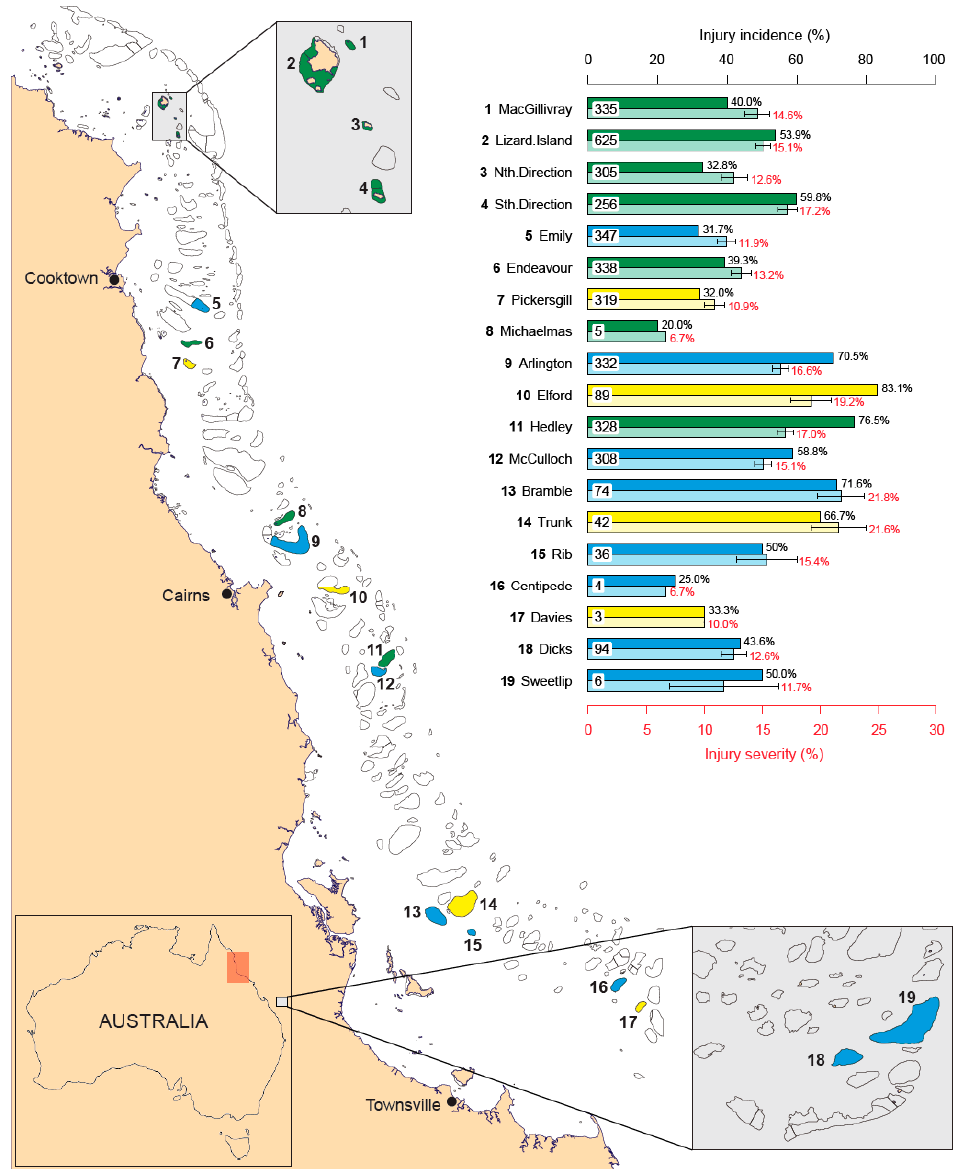
Figure 2. Map indicating sampled reefs along the Great Barrier Reef (GBR). The red box on the map of Australia shows the extent of the main map, whilst the reefs sampled in the Swains Region on the south-eastern end of the GBR are magnified in the bottom right rectangle. The colour of sampled reefs designates fishing regulations: green = no fishing (marine reserve), yellow = restricted fishing allowed, blue = open to fishing. The bar graph shows injury incidence per reef (top paired bar with solid fill and black values) and mean ± SE injury severity per reef (lower paired bar with semi-transparent fill and red values). Numbers in the white boxes within the bars represent the total number of individuals collected per reef. Injury severity values were calculated based on injured individuals only.